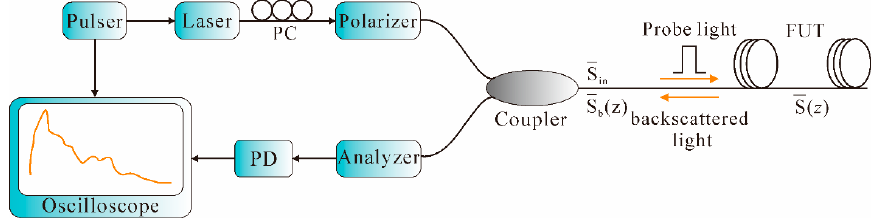
Figure 13. Basic arrangement of POTDR system.